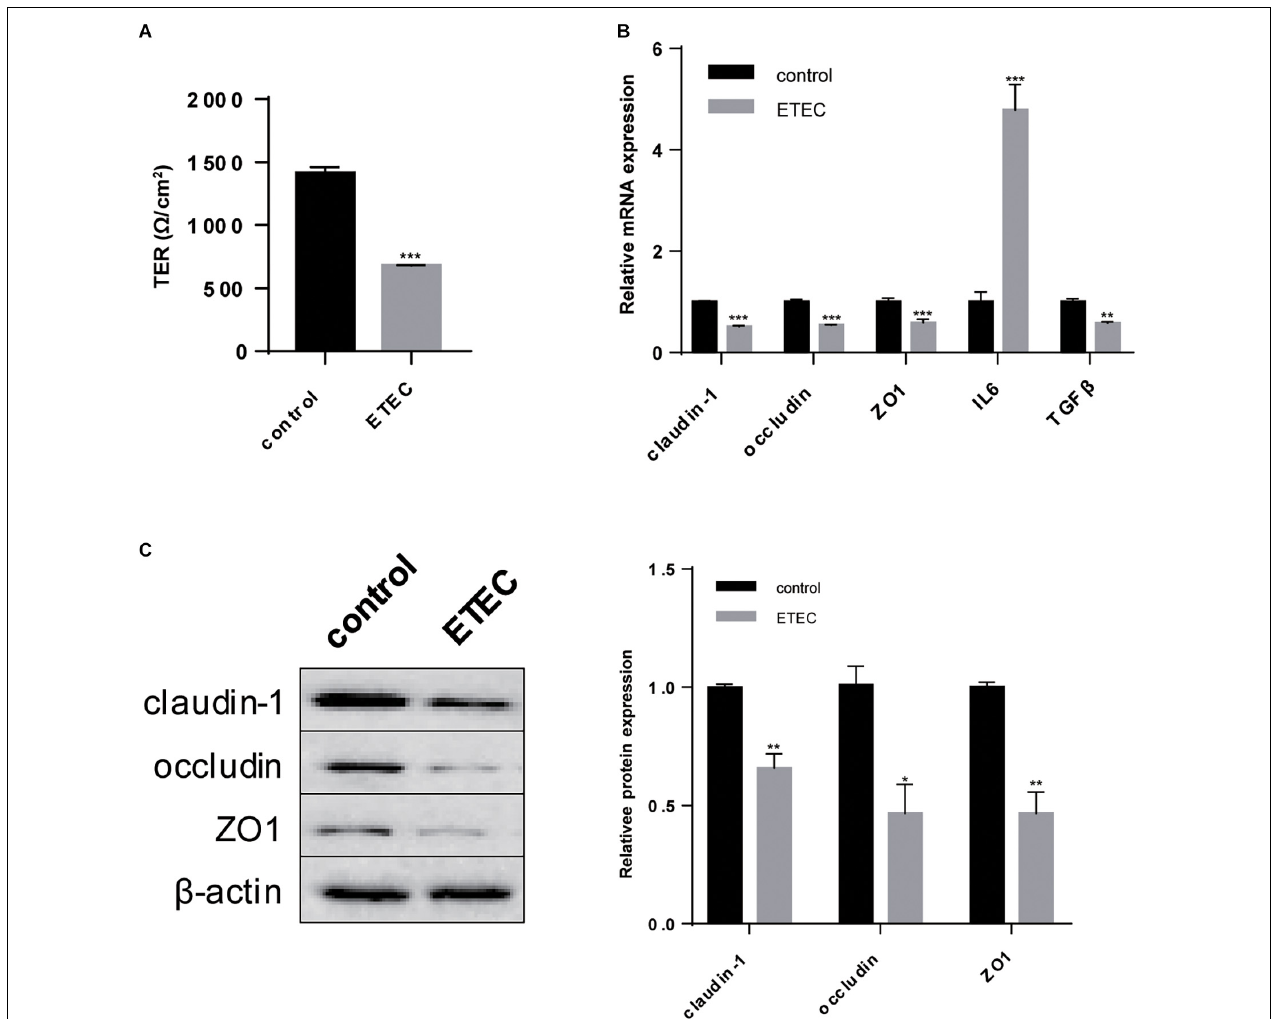
FIGURE 3 | ETEC challenge paralyzed intestinal barrier of polarized IPEC-J2 cell line. (A) TER measurement. (B) RT-qPCR analysis of TJs claudin-1, occludin, and ZO1; proinflammatory factor IL6 and inflammatory cytokine TGF β . (C) Western-blot analysis of TJs claudin-1, occludin, ZO1. Data are presented as mean ± standard error. ∗ P < 0.05, ∗∗ P < 0.01, and ∗∗∗ P <